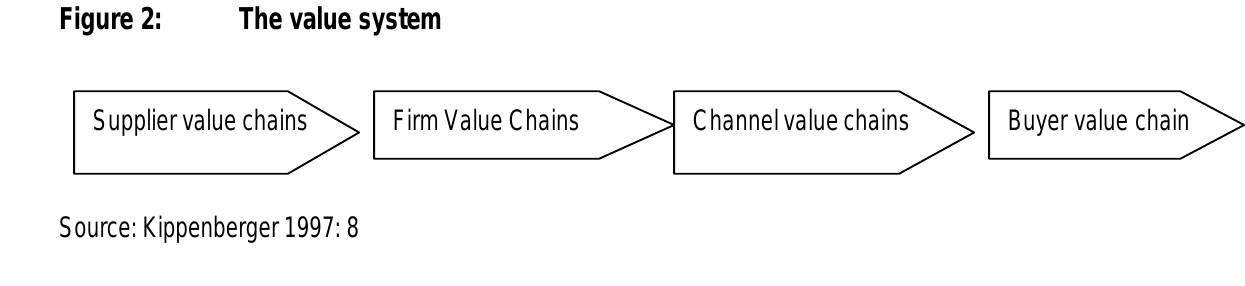
Figure 2: The value